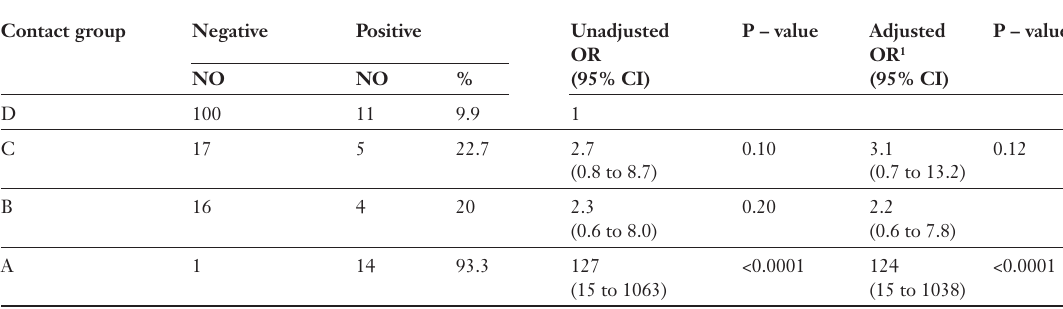
QTF – GiT results of all contacts. dotted lines indicate cut-off values at 0.35 iU/ml and 0.5 iU/ml forTB- specific antigens (a, left) and Phyto- haemagglutinin, ie mitogen (b, right).